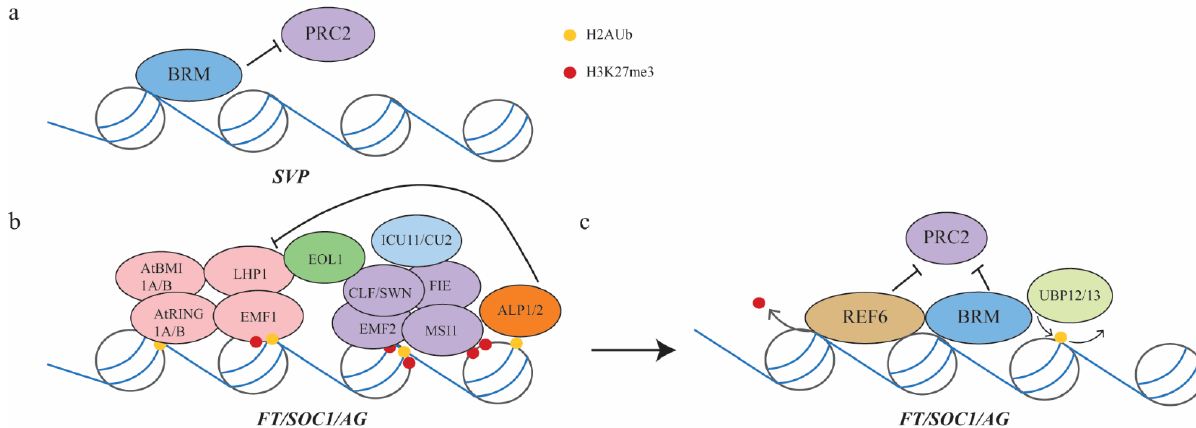
Figure 4. Model of PRC1 and PRC2 action during vegetative-to-reproductive phase transition. ( a ) BRM binds to the flowering repressor SVP to prevent PRC2 binding and maintain SVP activity during vegetative development. ( b ) Flowering activators FT/SOC1/AG are repressed after germination by the activities of both PRC1 and PRC2 to prevent precocious flowering and allow proper vegetative development. Both PRC1 and PRC2 bind to them. EOL1 and ICU11/CU2 act as PRC1 or PRC2 accessory proteins to assist with silencing. ( c ) Upon floral induction, UBP12/13 remove H2Aub, while REF6 removes H3K27me3 and recruits BRM at FT/SOC1/AG to prevent further PRC2 binding and allow activation of FT/SOC1/AG .